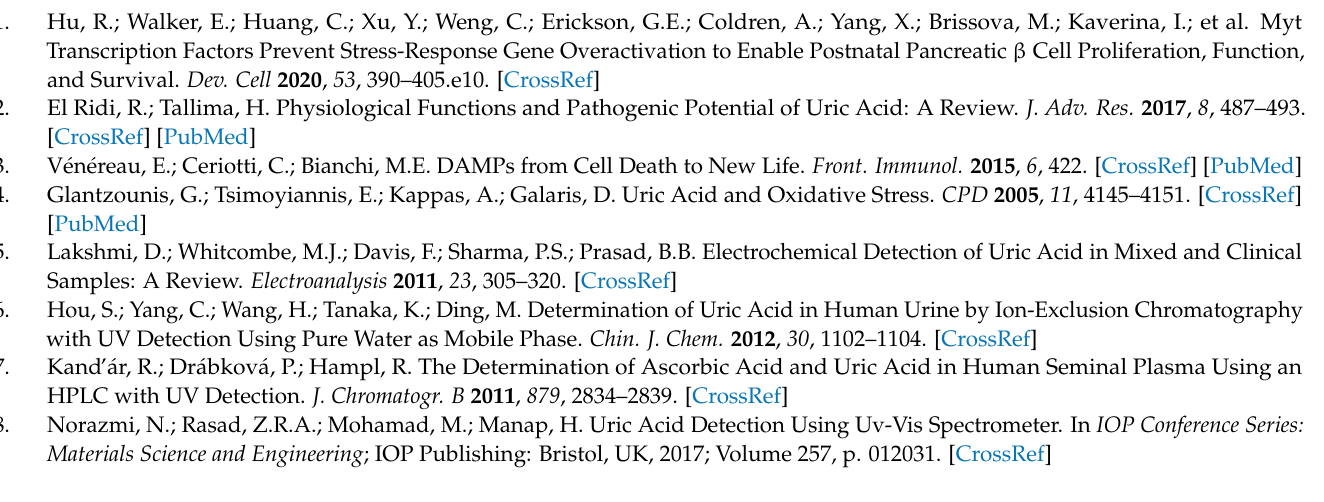
Figure S3. (A) CV in 0.1 M PB pH 6 in the presence of 10 µ M UA—unmodified CP electrode and electrodes modified with 2% of La(OH) 3 , MWCNT and La(OH) 3 @MWCNT (B) CV in 0.1 M PB pH 6 in the presence of 10 µ M UA—electrodes modified with 2%, 5% and 10% of La(OH) 3 @MWCNT (C) CV in 0.1 M PB pH 6 in the presence of 7.5; 10 and 100 µ M UA using electrode modified with Figure S5. Studying the impact of potential interferents on UA detection (A) CV in 0.1 M PB pH 6, at the potential range from − 0.05 V to 1 V at the scan rate 50 mV/s, (B) Histogram—percent of the anodic peak current which arose from the oxidation of UA. Figure S6. (A) CV in the potential range from 0.5 V to 1 V at the scan rate of 50 mV/s in the biological matrix in the presence and absence of UA (B) Amperometric curve of UA in the real sample matrix (inset B) Calibration curve of UA standard solutions in the biological